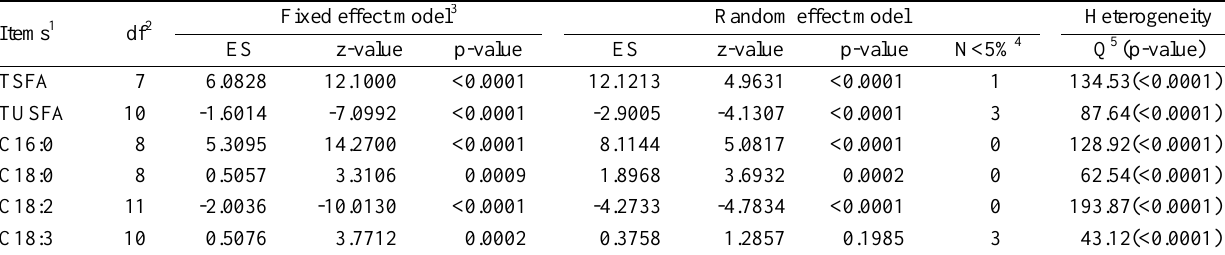
Table 3. Effect of CLA feeding on fatty acid profiles of chicken thighs Items 1 df 2